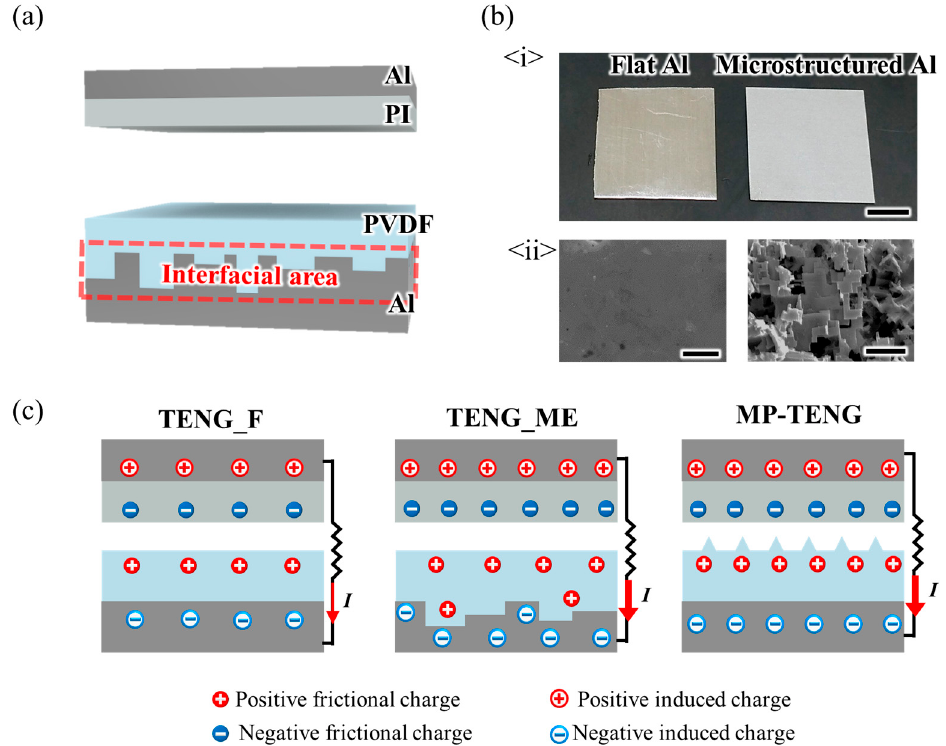
Figure 1. Fabrication of the TENG with a flat aluminum (Al) electrode (TENG_F), the TENG with a microstructured Al electrode (TENG_ME), and the TENG consisting of a flat Al electrode and a dielectric layer with micropyramid surface topography (MP-TENG). ( a ) Schematic diagram of polyimide (PI) counter layer and the TENG_ME which is composed of the polyvinylidene fluoride (PVDF) film and the microstructured Al electrode. ( b ) <i> Images of a flat Al electrode and a microstructured Al electrode. The scale bar is 1 cm. <ii> The scanning electron microscopy (SEM) images of the flat Al electrode and the microstructured Al electrode. The scale bar is 5 µ m. ( c ) Expected difference between TENG_F, TENG_ME, and MP-TENG.